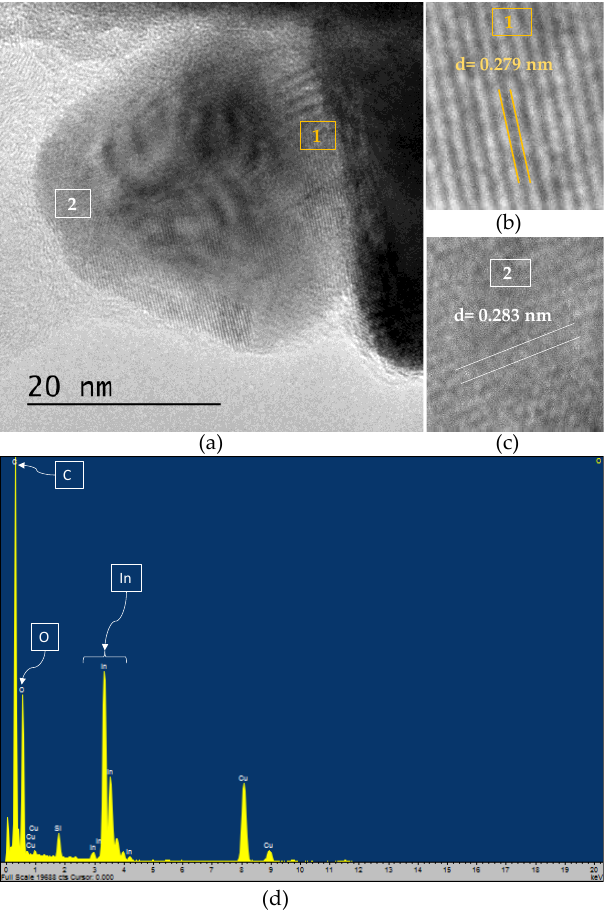
Figure 4. ( a ) HR-TEM micrograph of In 50 /C 50 nanoparticles; ( b , c ) detail of lattice fringe spacings on spherical nanoparticles; ( d ) EDX pattern showing the elemental composition of the nanoparticles. On the other hand, the CO 2 RR performance of In KOH , In H2O and the In foil has been evaluated in a solution saturated with CO 2 on the potential range from − 1.15 V to − 1.8 V (represented with dashes in Figure 5). The change in the pH once CO 2 saturates the solution (pH CO2 = 7.42) in contrast to that when using Ar (pH Ar = 9.33), results in a shift to more negative potentials at which the reduction processes take place. Thus, the reduction onset potentials for In KOH , In H2O and In foil were − 1.35 V, − 1.42 V and − 1.25 V vs. Ag/AgCl, ( − 15.20 mA · cm geo − 2 ) as compared to that obtained by In H20 ( − 12.08 mA · cm geo − 2 )